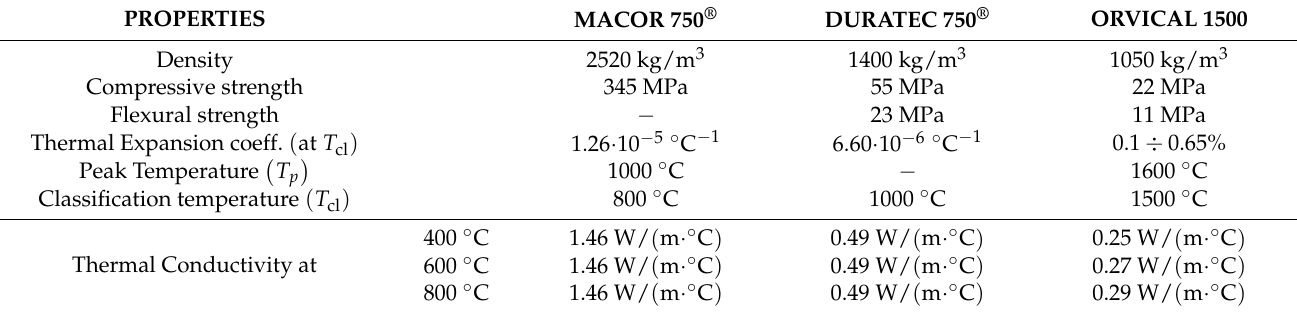
Table A6. Mechanical and thermal properties of PROMAFORM ( r ) ECO 1250, see